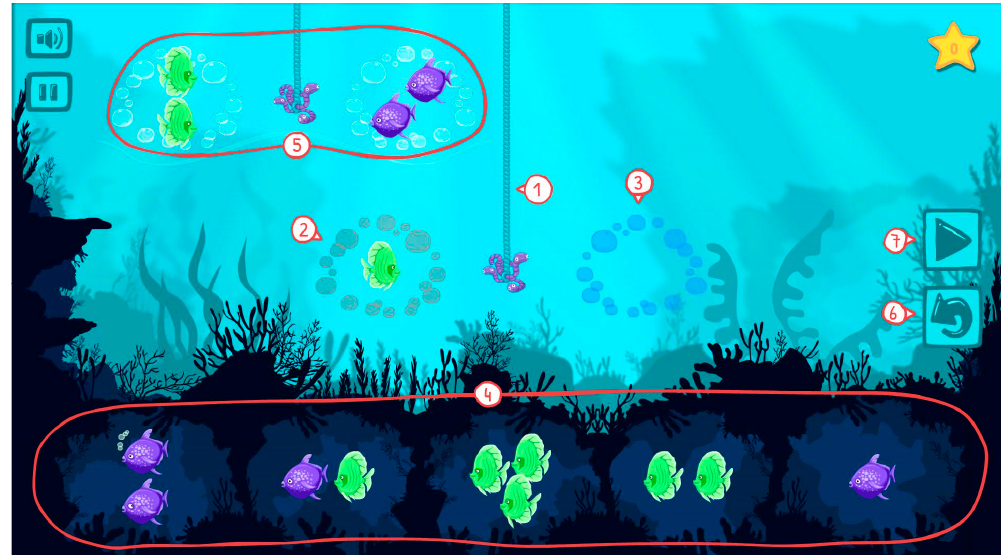
Figure 1. Sample task and individual game features of Triton.